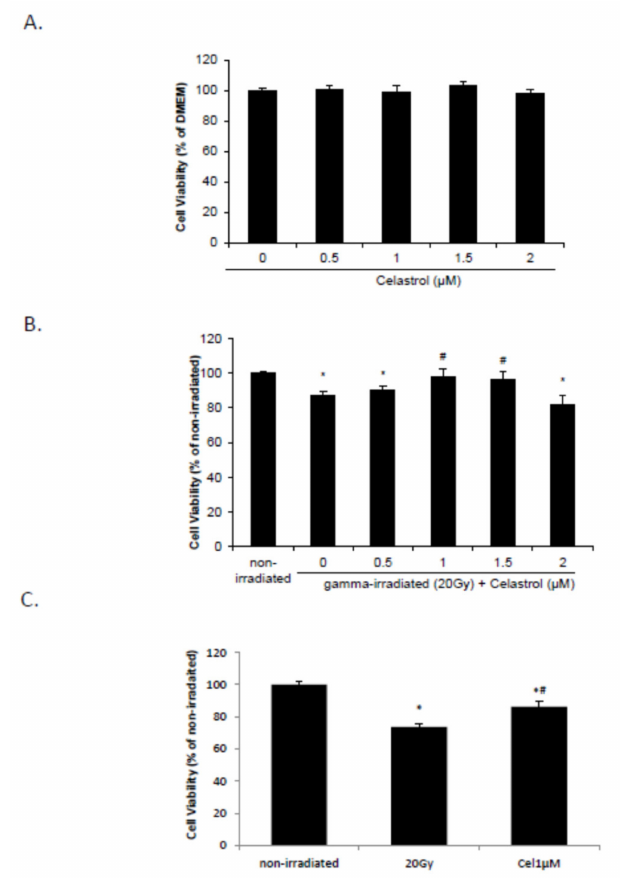
Figure 1. Cell viability after celastrol treatment in HaCaT cells and human skin fibroblast cells. ( A ) HaCaT cells were treated with celastrol at various concentrations of 0, 0.5, 1, 1.5, and 2 µ M without gamma radiation. Cell viability was evaluated by MTT after 24 h. ( B ) HaCaT cells were subjected to gamma irradiation with 20 Gy followed by 24 h treatment with celastrol at various concentrations, and cell viability was evaluated by MTT. Dulbecco’s modified Eagle medium (DMEM) group without any drug treatment and gamma radiation served as control. ( C ) Human skin fibroblast cells were subjected to gamma irradiation with 20 Gy, followed by celastrol treatment at 1 µ M. Cell viability was evaluated by MTT 24 h post-exposure. Eagle’s Minimum Essential Medium (EMEM) group without any drug treatment and gamma radiation served as control. All data are expressed as mean ± S.E.M ( n = 5). Comparisons between groups were analyzed by One-Way ANOVA followed by Tukey’s post-hoc test. * p < 0.05 vs. non-irradiated. # p < 0.05 vs. irradiated and no drug